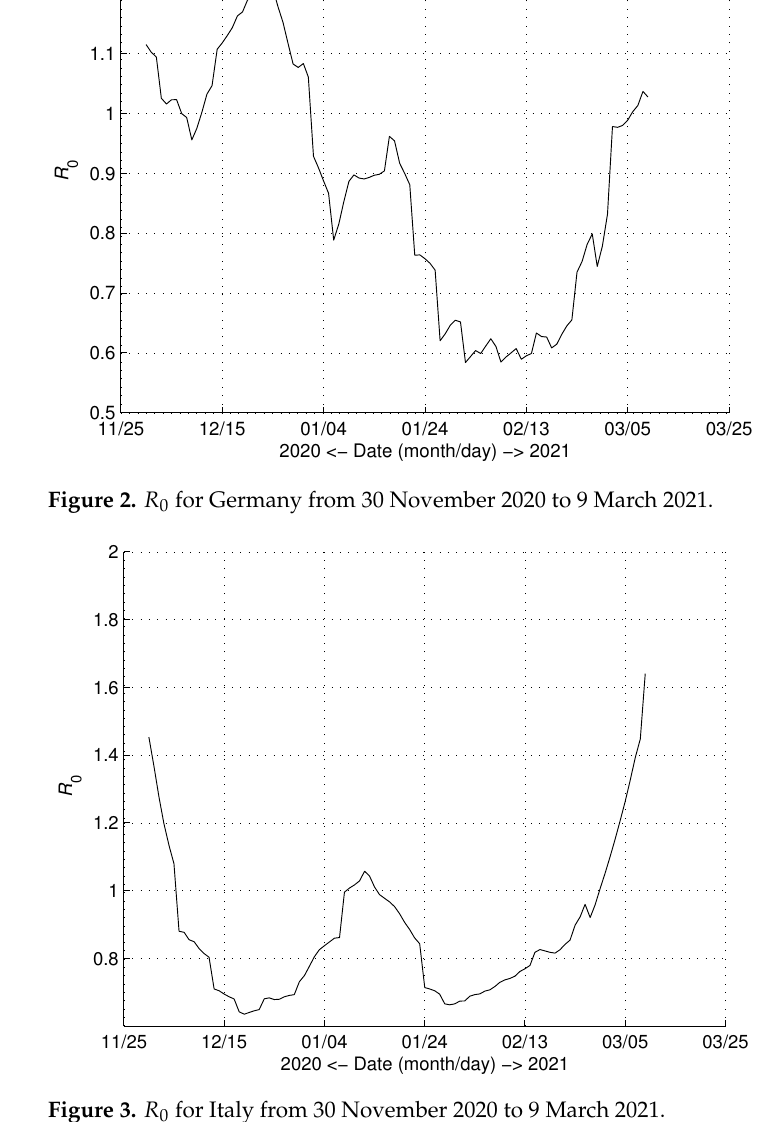
Figure 3. R 0 for Italy from 30 November 2020 to 9 March